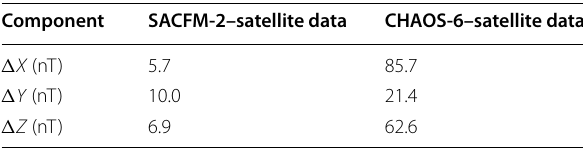
Table 6 The RMS values of the differences between the SACFM-2 and CHAOS-6 main field models and measured satellite data at four reference group points (G1, G2, G3 and G4) for selected epochs in Table